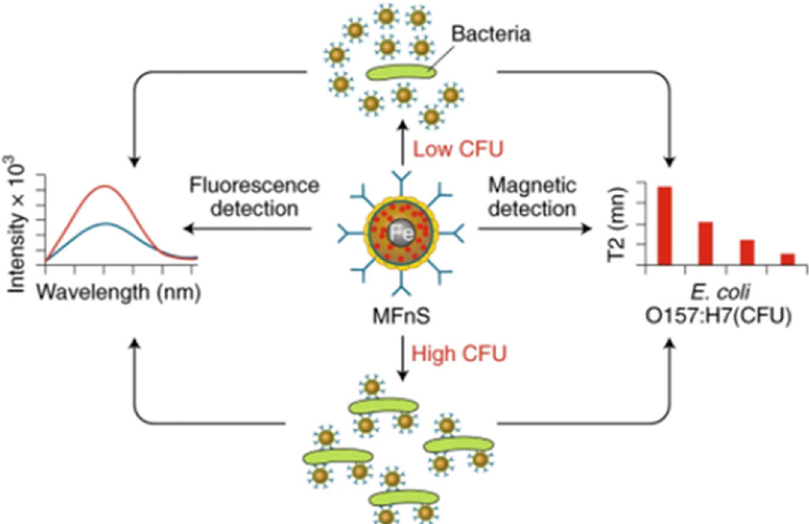
Fig. 10 Magnetically based nanosensor architecture for environmental analyte detection. Combined magneto- fl uorescence approach is applied to sense and detect bacteria via fl uorophore labeled magnetic nanoparticles. Fluorescence and magnetic bacterial sensing are achieved by functionalizing speci fi c antibodies of E. coli with magneto- fl uorescent nanosensors (reprinted with permission from 183 ; Copyright © ACS, 2016).